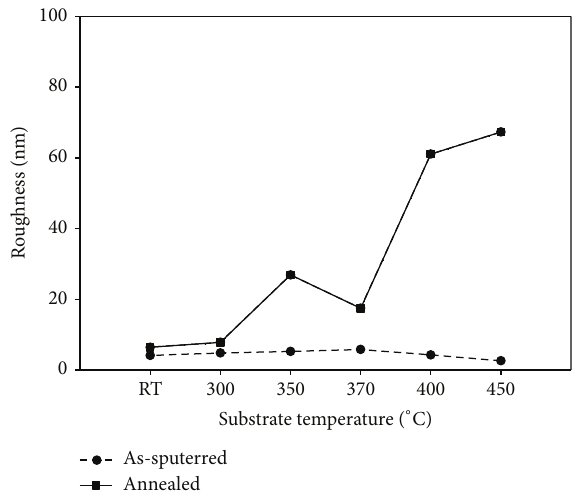
Figure 7: Improvement in crystallite size of as-sputtered and annealed films from SEM